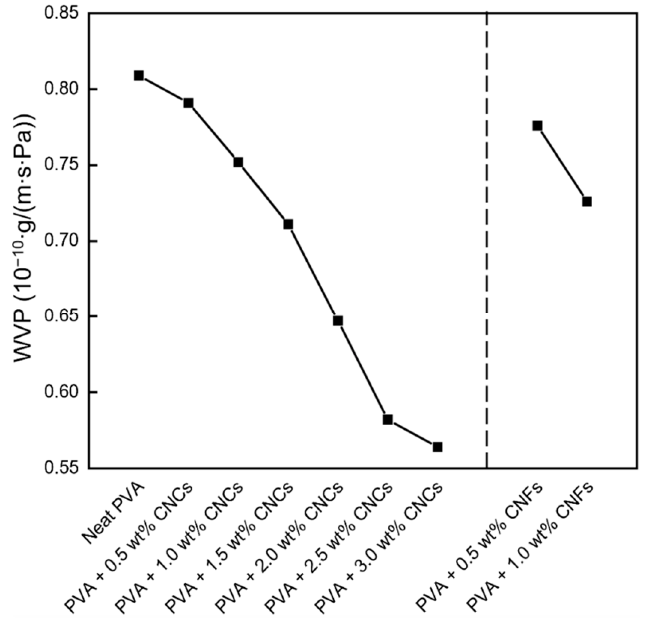
Figure 7. Water vapor permeabilities of the PVA + CNC/CNF nanocomposite films.